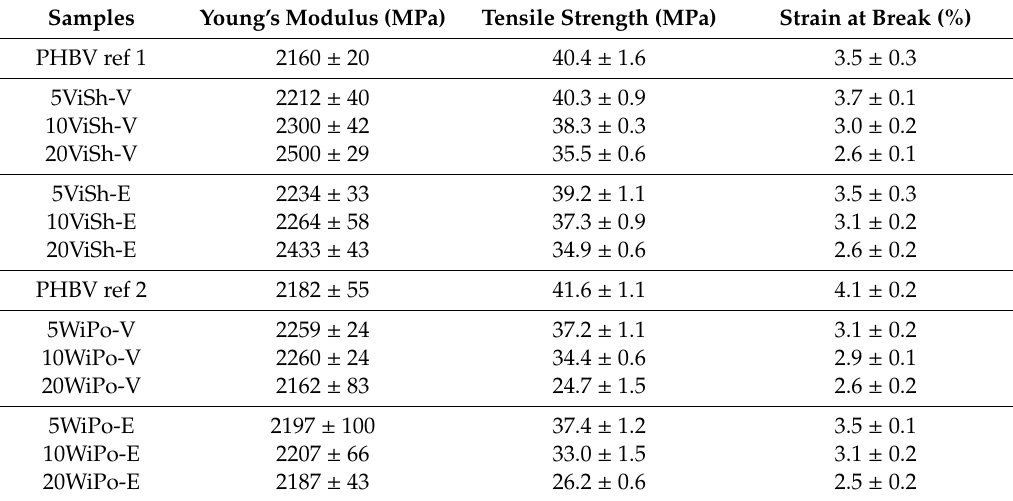
Table 6. Mechanical properties of the ViSh- and WiPo-based composite-injected molded